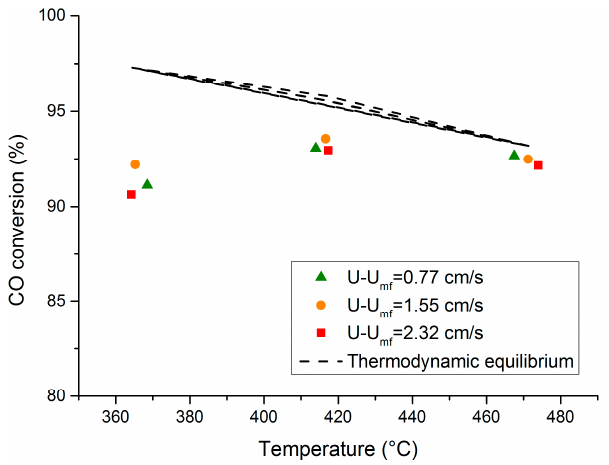
Figure 2. Performance of the conventional fluidized bed reactor a function of the operating temperature at different excess velocities (U-U mf ) for WGS. Feed: CO (10%), H 2 O (30%), N 2 (balance), reactor at 1 bar .